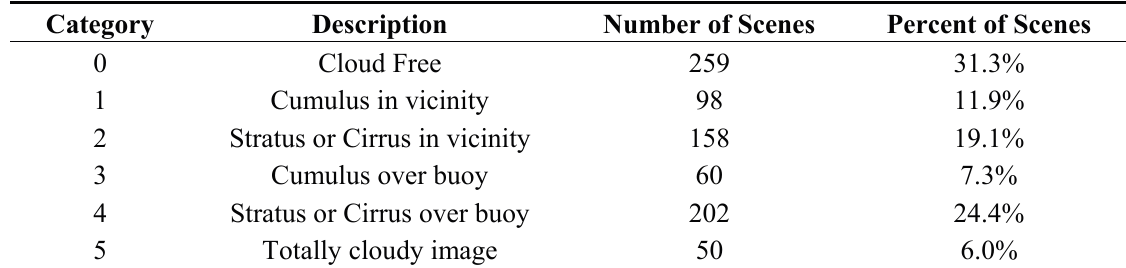
Table 1. Description of visual cloud screening